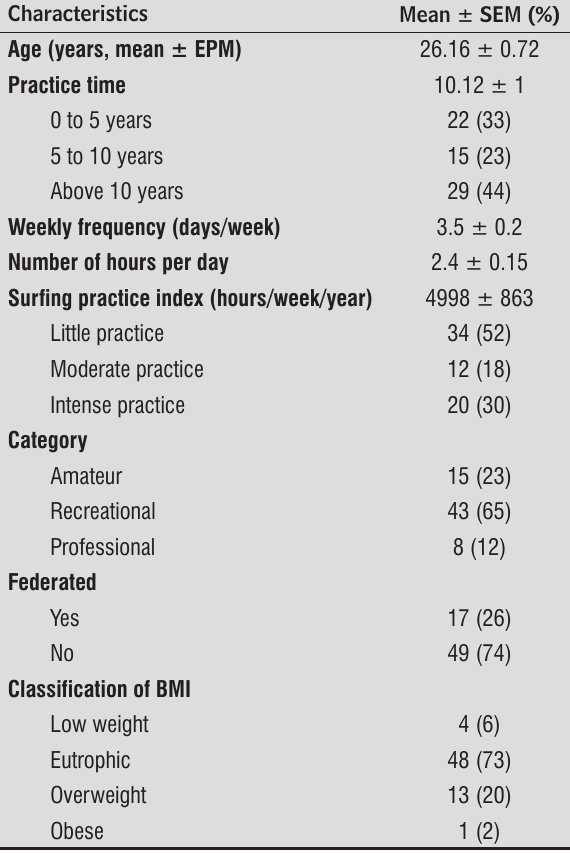
Table 1 - Demographic, anthropometric and physical char- acteristics of participants (n =